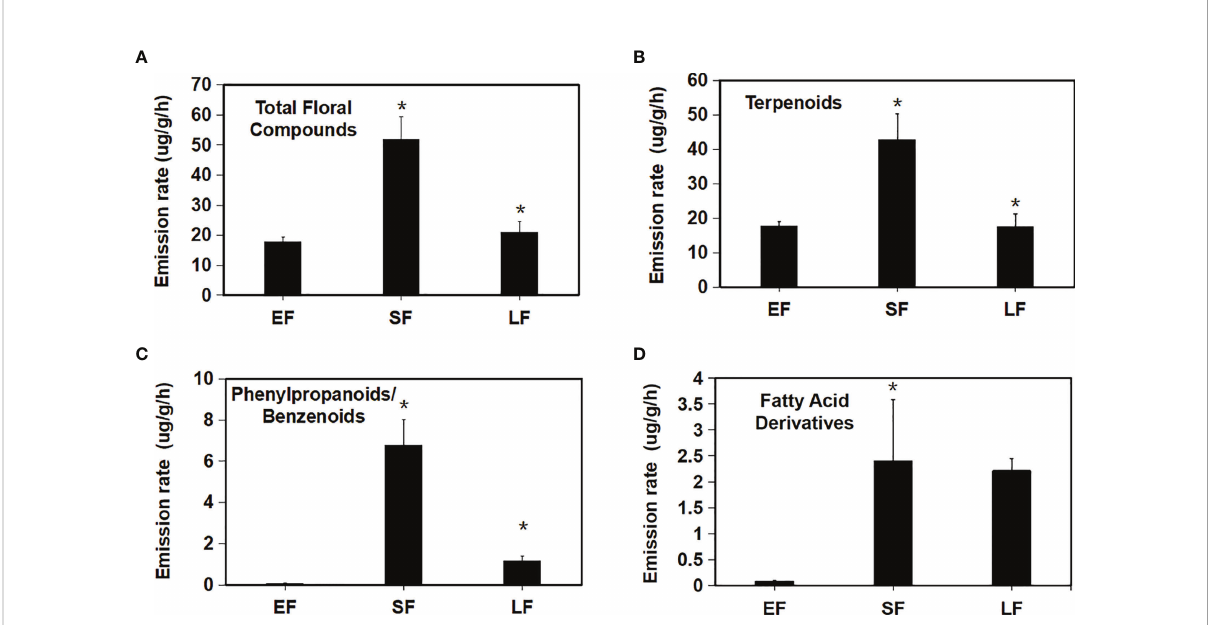
FIGURE 2 Variation in compound emission rates across fl ower developmental stages in Rosa hybrida ‘ Tianmidemeng ’ . (A) Emission variation of total compounds across fl ower developmental stages; (B) Emission variation of fl oral terpenoids across fl ower developmental stages; (C) Emission variation of fl oral phenylpropanoids/benzenoids across fl ower developmental stages; (D) Emission variation of fl oral fatty acid derivatives across fl ower developmental stages. Emission rates during SF were the greatest for nearly all fl oral compounds. Means with asterisk (*) are signi fi cantly different (Student ’ s t test, P <